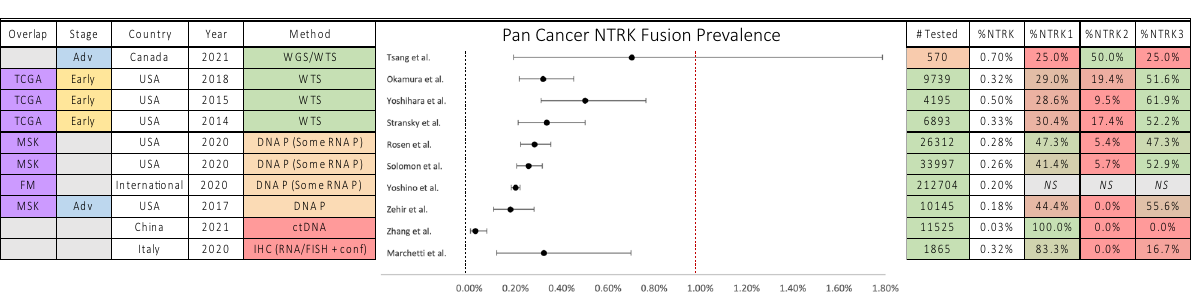
Figure 2. Landscape of included studies. ( a ) Number of studies by publication year; ( b ) relative proportion of studies by cancer type investigated. Mar-2021—number of studies from 01/01/2021 until 31/03/2021.